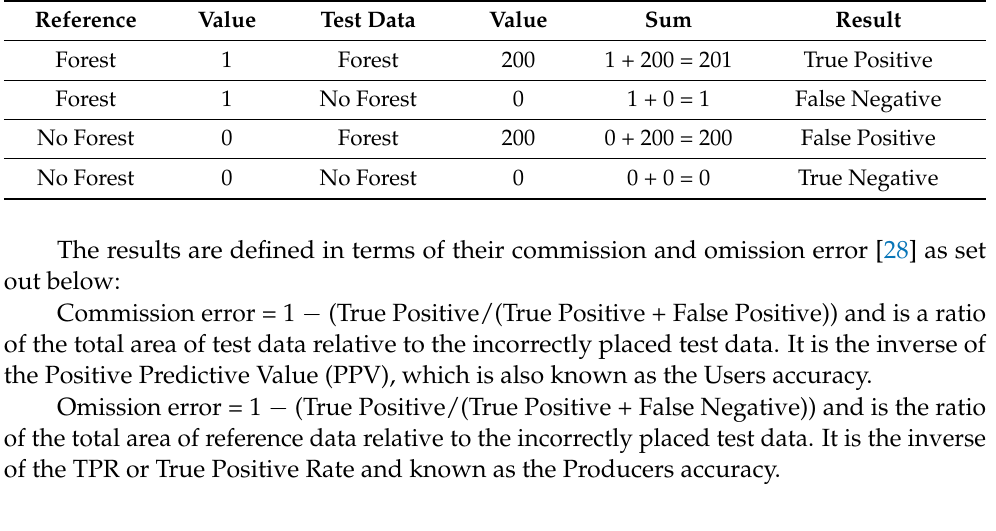
Table 2. Reference data vs. test data